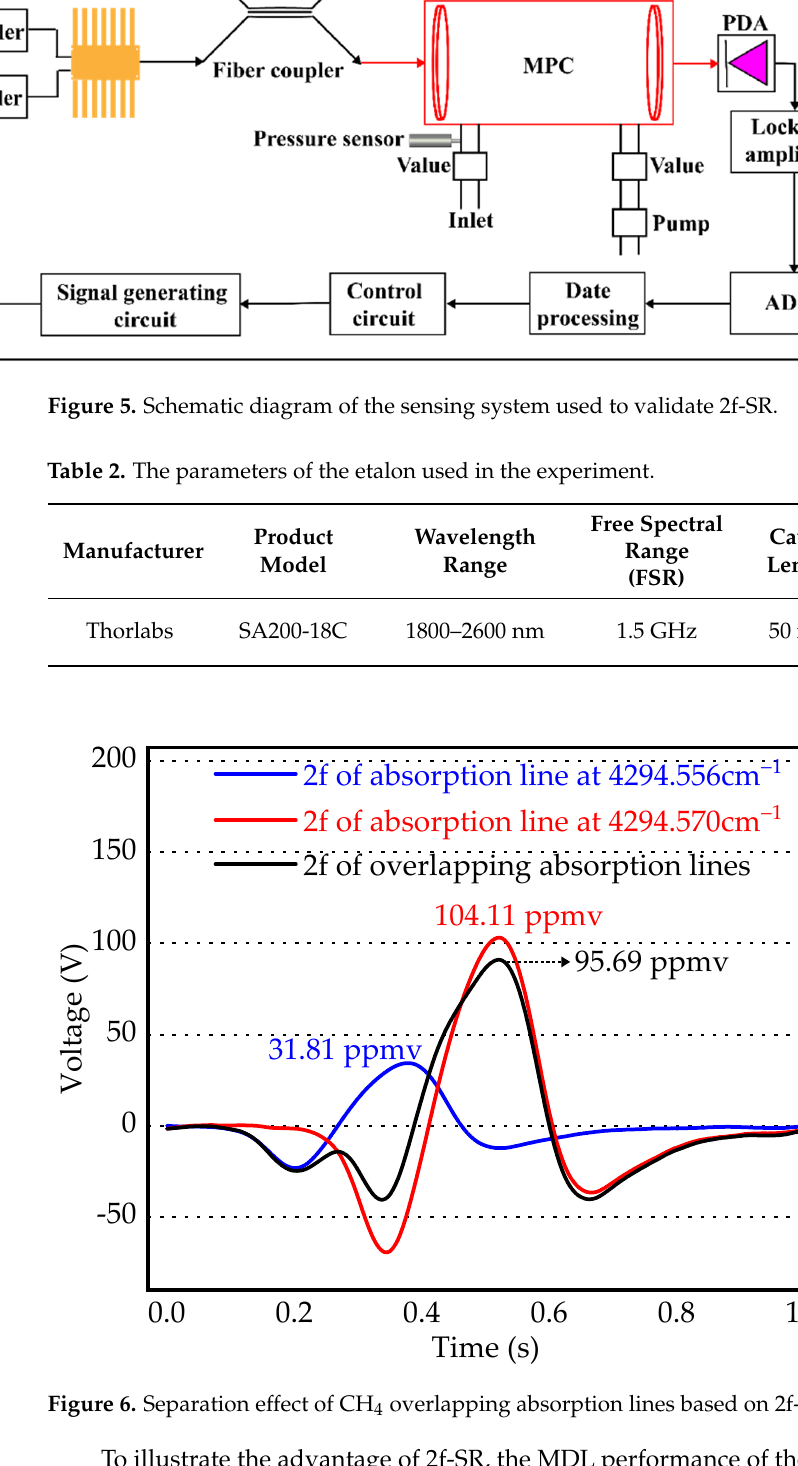
Figure 7. Allan variance of 2f-SR data of a 100 ppmv CH 4 standard gas. The response of the sensing system to a 50 ppmv CH 4 standard gas was measured independently six times in a laboratory environment to verify the effect of 2f-SR on the measurement accuracy. Raw data and 2f-SR data are presented in Figure 8. The raw meas- urement error was 4%, and the measurement error after 2f-SR was 0.8%. The measurement